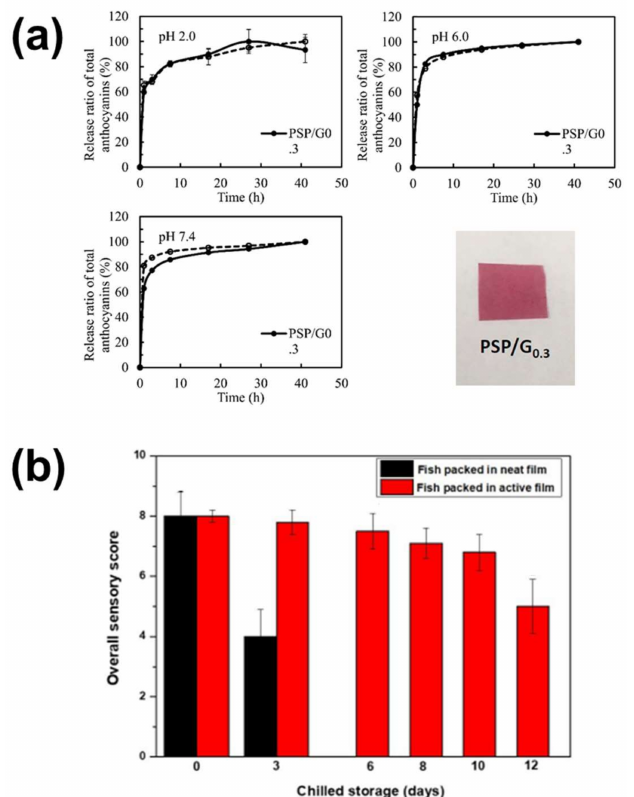
Figure 8. ( a ) The gellan gum/purple sweet potato-based films (PSP/G 0.3 ) and their 40-h-long release profiles in different pH conditions (2, 6, and 7.4). Interactions between the gellam gum and the phenolic compounds resulted in a slower release profile for pH 2. Adapted with permission from Ref. [130]. ( b ) The color, odor and texture sensory scores of packaged fish without and with the application of active cellulose/PVA based films with rose petal anthocyanins, which manage to conserve it for 12 days. Adapted with permission from Ref.